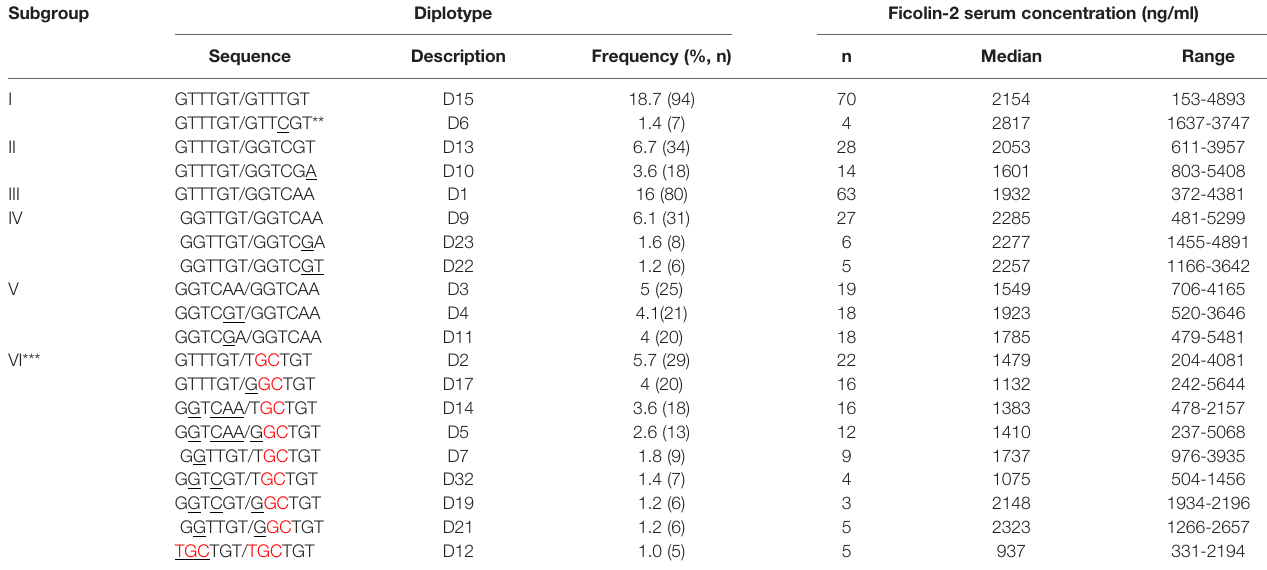
TABLE 5 | The subgroups including identi fi ed diplotypes (with the frequency ≥ 1%*) in preterm neonates. Subgroup Diplotype Ficolin-2 serum concentration (ng/ml)